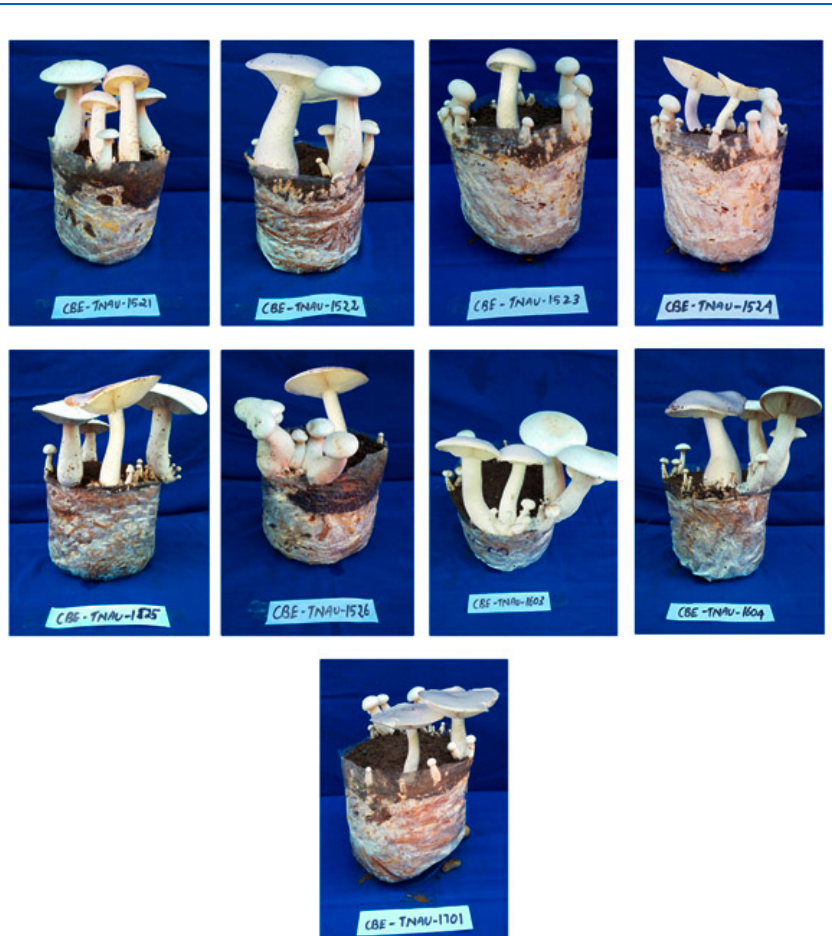
Fig. 2a, b. Morphological evaluation of milky mushroom